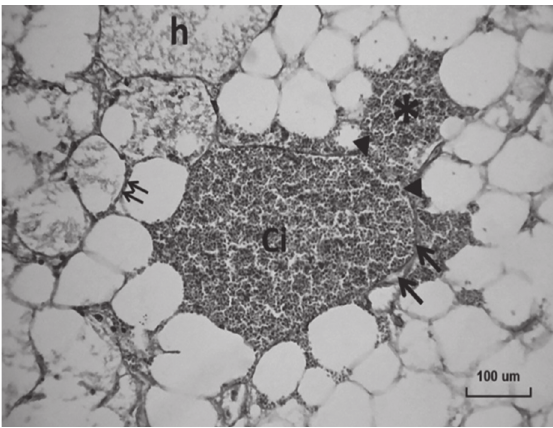
Figure 2 - Gobioides grahamae . Microsporidium sp. Light photomicrograph showing the dislocated threads of vacuo- lated hepatocytes, hyaline intracellular deposits (h), and the thickening of the cell membrane of the hepatocytes (small arrows) associated with a Microsporidium sp. cyst (Ci) with a capsule of conjunctive tissue (large arrows) which has ruptured (arrowheads), releasing spores among the hepatocytes (*). Masson’s trichrome staining. Scale bar = 100